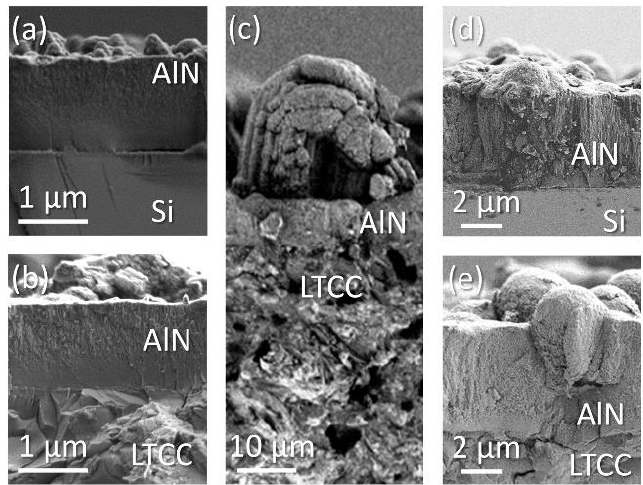
Figure 4. Scanning electron microscope (SEM) micrographs of sputtered aluminum nitride (AlN) layer cross sections (N 2 :Ar = 0); ( a ) #1 on silicon; ( b ) #1 on ceramic; ( c ) #5 on ceramic; ( d ) #9 on silicon and ( e ) #9 on ceramic.